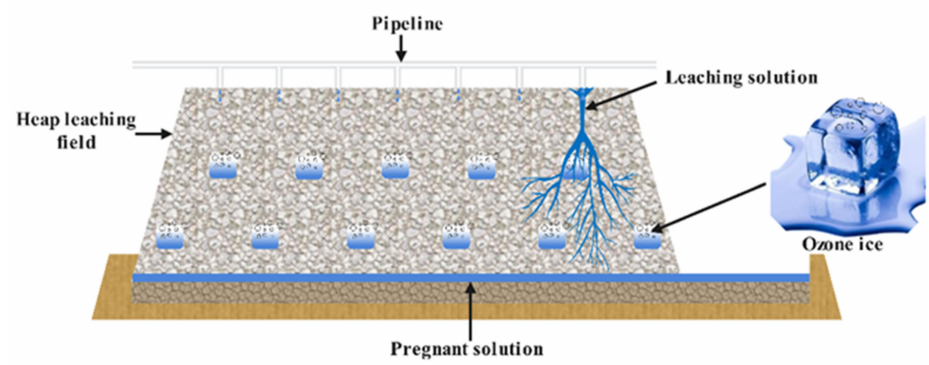
Figure 1. Diagram of ozone ice pre-embedding in gold ore leaching heap.